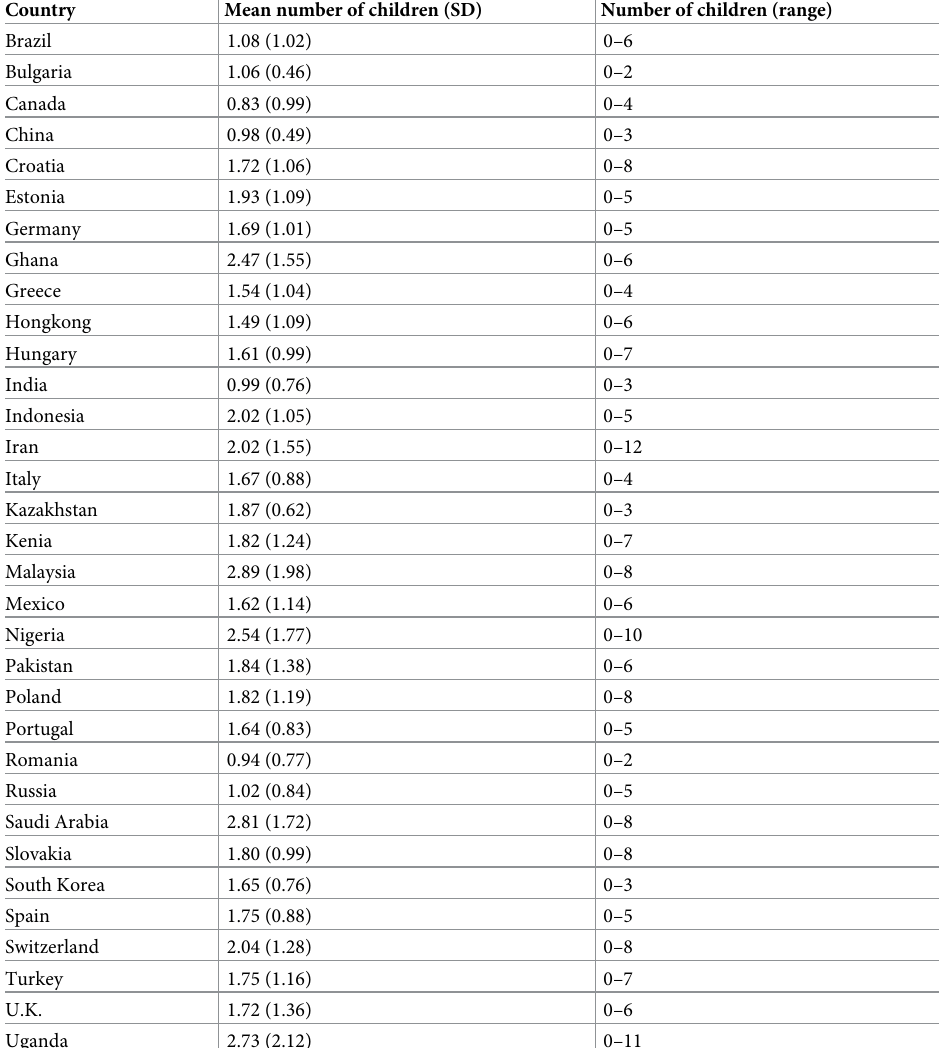
Table 1. Characteristics of participants’ number of children across the countries.